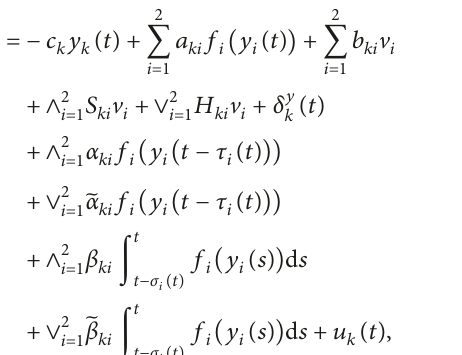
Figure 2: (a) Trajectories of x response system without